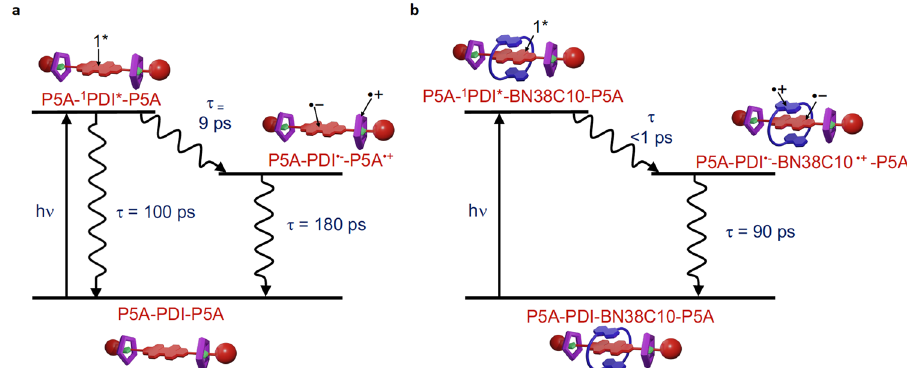
Fig. 6 Proposed decay pathways for [PDI-(P5A) 2 ] 2 + and [PDI-BN38C10-(P5A) 2 ] 2 + . a Following excitation [PDI-(P5A) 2 ] 2 + forms a 1 PDI excited state which undergoes partial charge separation in 9 ps to form the PDI • − species. The 1 PDI decays via internal conversion (IC) after 100 ps, with the PDI • − species undergoing recombination back to the ground state after 180 ps. b When [PDI-BN38C10-(P5A) 2 ] 2 + is photoexcited it quickly undergoes charge separation from a 1 PDI in less than 1 ps, forming the PDI • − species which undergoes recombination back to the ground state after 90 ps. Crystallographic studies Single crystal X-ray diffraction studies . Single crystals of [PDI-BN38C10-(P5A) 2 ] α = 102.330(7)°, β = 95.182(6)°, γ = 102.574(6)°, V = 4482.7(6) Å3, Z = 1, (PF 6 ) 2 were grown from a solution of the compound dissolved in CHCl 3 containing T = 100(2)K, μ (Synchrotron) = 0.347 mm − 1 , D calc = 1.425 g/cm3, 19267 1mM [ n Bu 4 N][BF 4 ]. A suitable single crystal was selected and mounted using fomblin fi lm on a micromount. Data were collected on a Fluid Film Devices 3-circle re fl ections measured (2.986° ≤ 2 Θ ≤ 31.988°), 4766 unique ( R int = 0.0984, diffractometer equipped with a Dectris Pilatus 2M detector. The crystals were kept R sigma = 0.0831) which were used in all calculations. The fi nal R 1 was 0.3410 at 100(2) K during data collection. Using Olex2 42 , the structures were solved with ( I >2 σ ( I )) and wR 2 was 0.6948 (all data). Details of dealing with disorder and other the ShelXT 43 structure solution programme using Intrinsic Phasing and re fi ned re fi nement are described in the corresponding, deposited cif, CCDC 2114986, but are also described in the Supplementary Information fi le for convenience. with the ShelXL 44 re fi nement package using Least Squares minimisation.